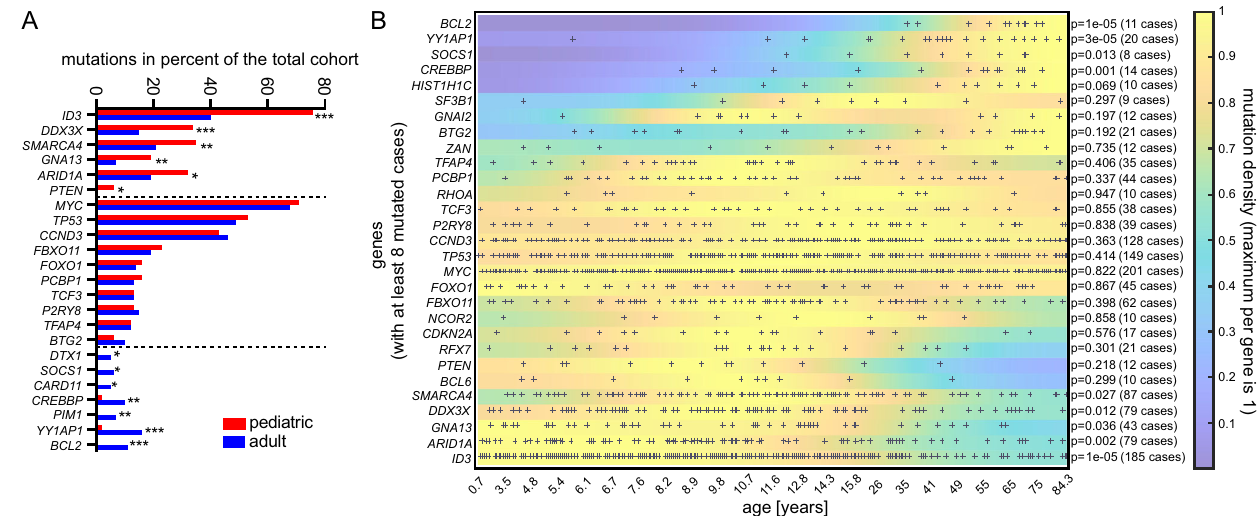
Fig. 3 Age dependency of the mutation pro fi le. A Comparison of mutation counts between age groups, using the usual age cutoff of 18 years for adult patients. Mutations in ID3 , DDX3X , SMARCA4 , GNA13 , ARID1A, and PTEN are signi fi cantly more frequent in pediatric patient samples, while BCL2 , YY1AP1 , PIM1 , CREBBP , CARD11 , SOCS1, and DTX1 are signi fi cantly more frequently altered in the adult cohort ( P values by one-sided exact Fisher tests, see Supplementary Data 8 for exact P values and FDRs, * P ≤ 0.05, ** P ≤ 0.01, *** P ≤ 0.001). B A cutoff-free enrichment analysis of mutation densities over age largely con fi rms cutoff-based results but reveals that the main biological transition of the mutational pro fi le occurs later between 25 and 40 years ( P values by one-sided enrichment analysis and permutation test with 1e5 permutations per